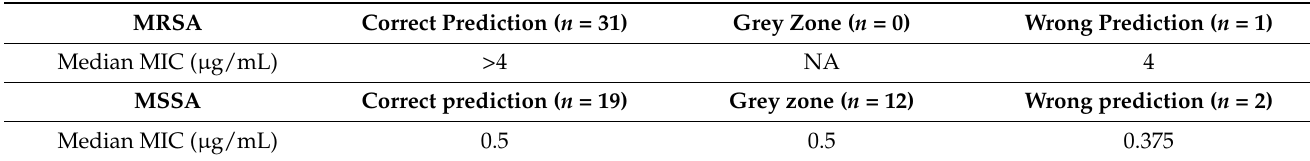
Table 3. MIC of oxacillin using broth microdilution method. Both MSSA and MRSA had no significant difference in MIC between groups.